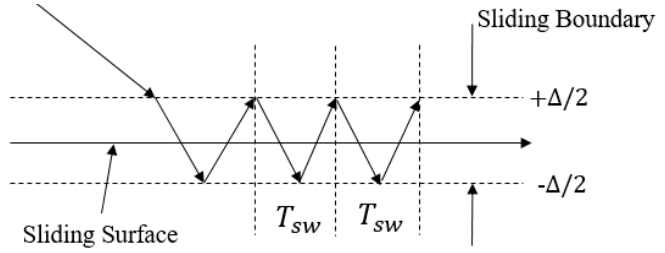
Figure 4. The chattering around the sliding surface.